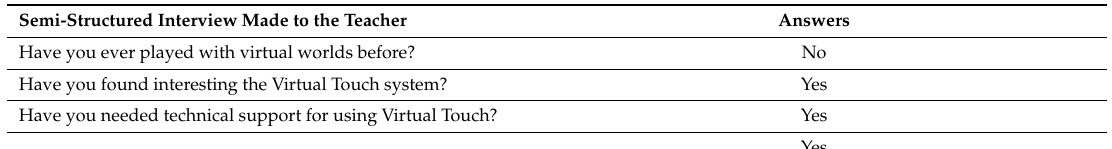
Table 4. Semi-structured interview with the